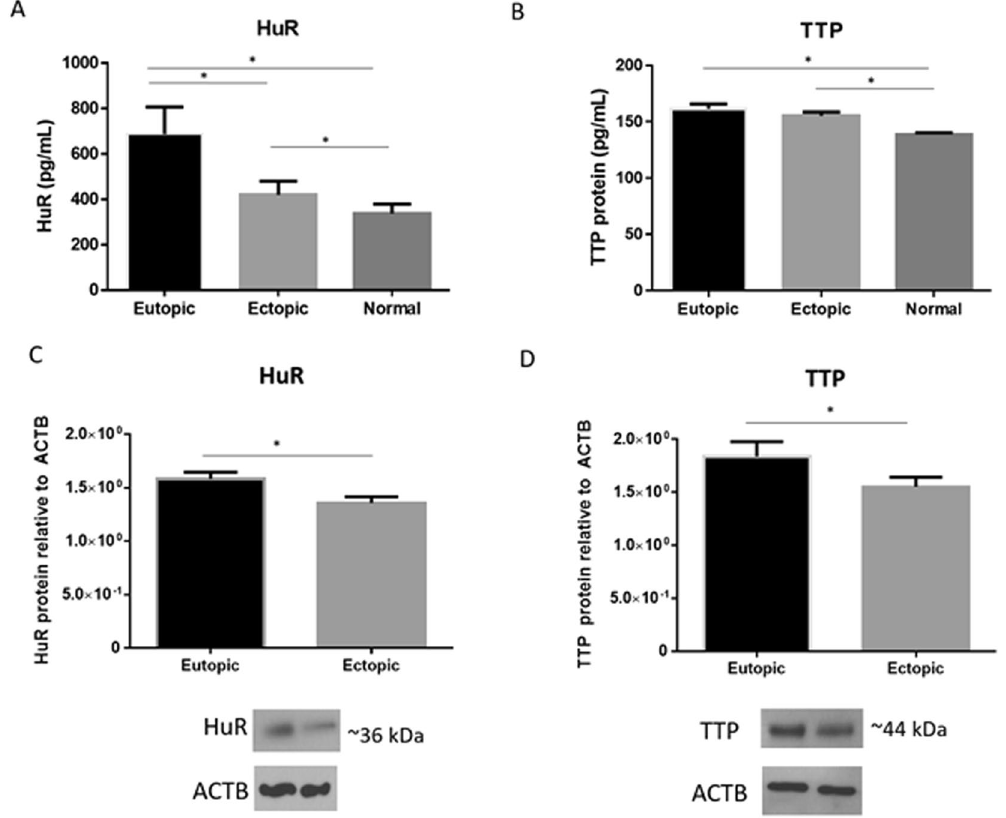
Figure 2. HuR/TTP axis protein levels are altered in patients with endometriosis: characterization using ELISA and western blotting in endometriosis patients and in normal fertile controls. Expression of HuR was significantly higher in eutopic endometrium compared to matched ectopic lesions from endometriosis patients as well as normal endometrium from healthy controls (Panel A). TTP protein was significantly higher in eutopic and ectopic matched endometrium from endometriosis patients compared to normal endometrium from healthy controls (Panel B). In a different cohort of women with endometriosis receiving dienogest, HuR and TTP protein was significantly higher in matched eutopic endometrium compared to ectopic lesions (Panels C,D, densitometry as ratio to ACTB and cropped blots are displayed. Full blot images are shown in Supplemental Figs 1 and 2). Expression data illustrated as mean ± SEM. * P < 0.05. Panels A,B (Greenville patient subset) consisted of n = 22 human eutopic endometrium, n = 22 human ectopic endometriotic lesions, n = 16 normal control endometrium. Panels C,D (Ottawa patient subset) consisted of n = 8 human eutopic endometrium and n = 8 human ectopic endometriotic